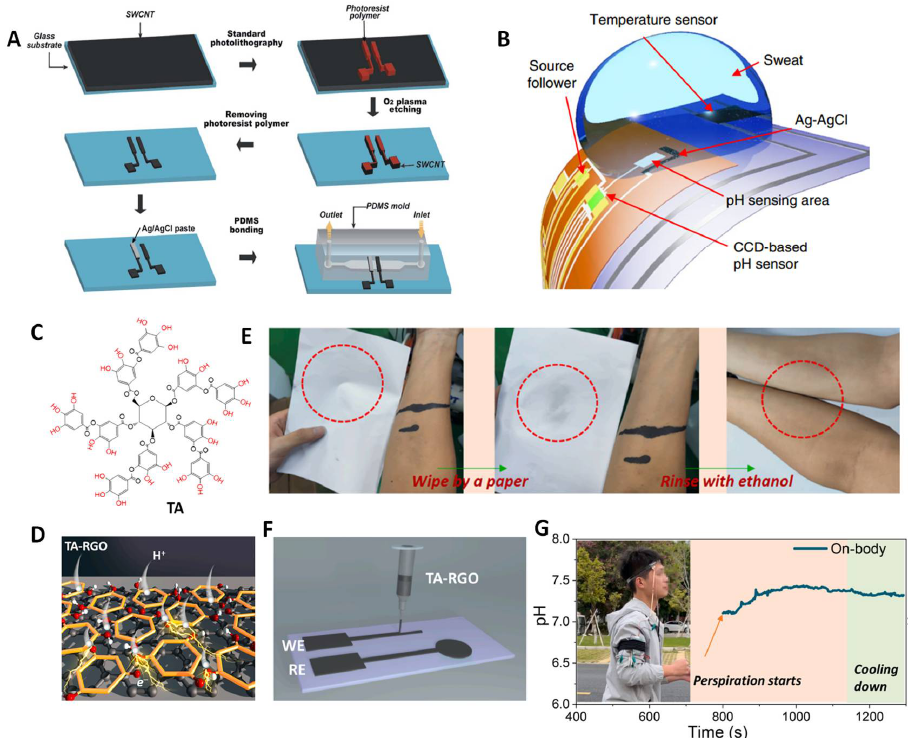
Figure 7. ( A ) The fabrication of a microfluidic pH-sensing chip. Reprinted with permission from [47], Copyright (2014) Royal Society of Chemistry. ( B ) A CCD−based flexible pH sensor integrated with a temperature sensor. Reprinted with permission from [115], Copyright (2018) Spring Nature. ( C – G ) Graphene−tannin supramolecule−based wearable potentiometric pH sensors. ( C ) Molecular structure of tannin (TA). ( D ) A schematic of TA−RGO supramolecular aggregates based on their π- π conjugation interaction. ( E ) Photographs of TA–RGO on the skin to test adhesion. ( F ) The wearable pH device was fabricated by directly printing TA–RGO on a flexible substrate. ( G ) Real–time sweat test of the flexible pH sensor. Reprinted with permission from [116], Copyright (2022)